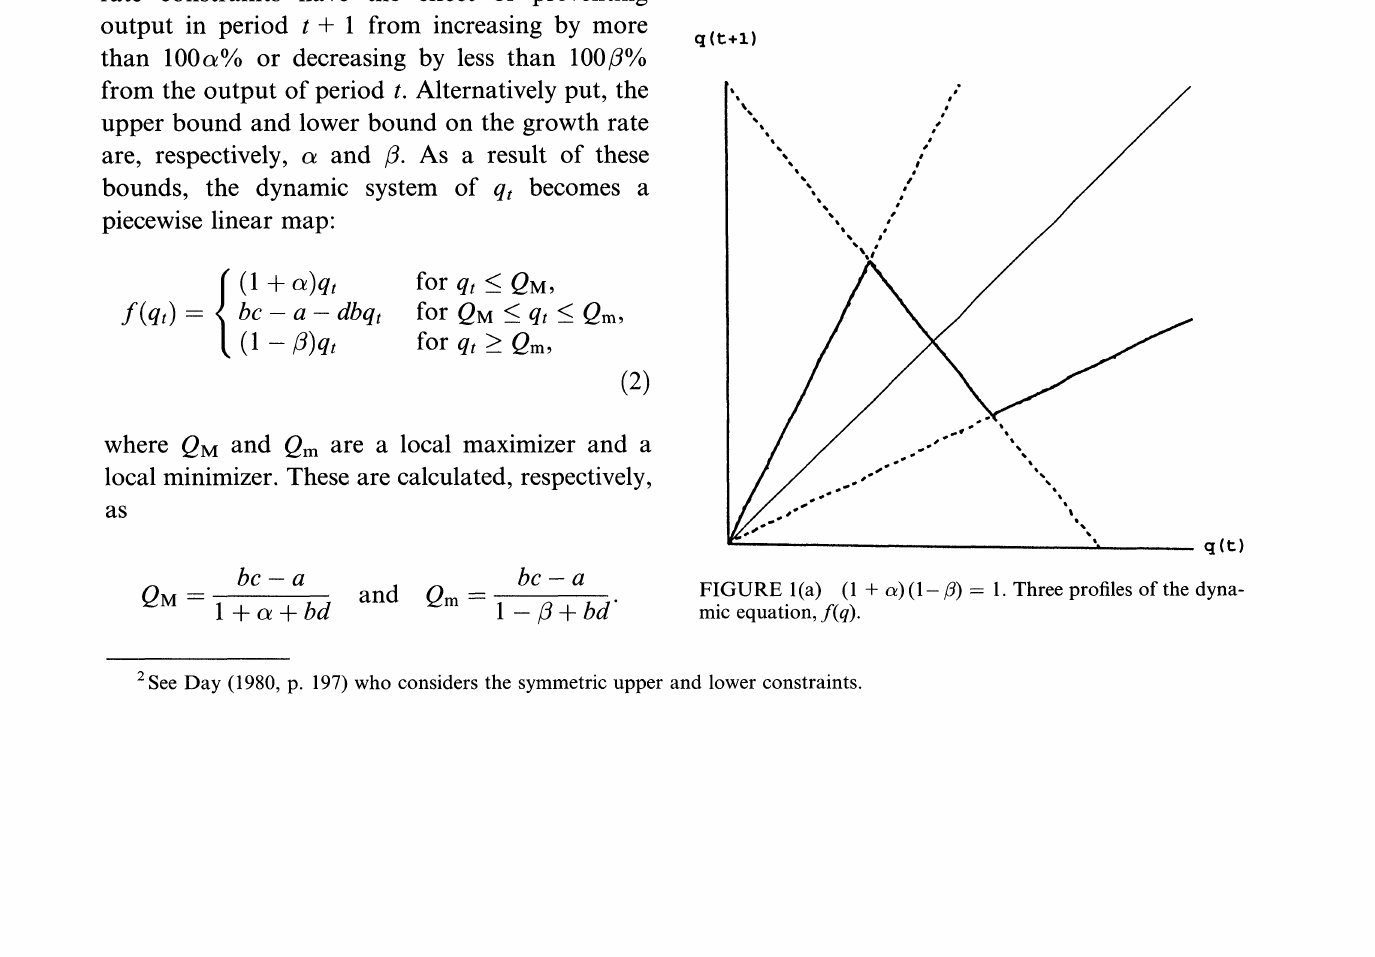
1. Three profiles of the dyna-